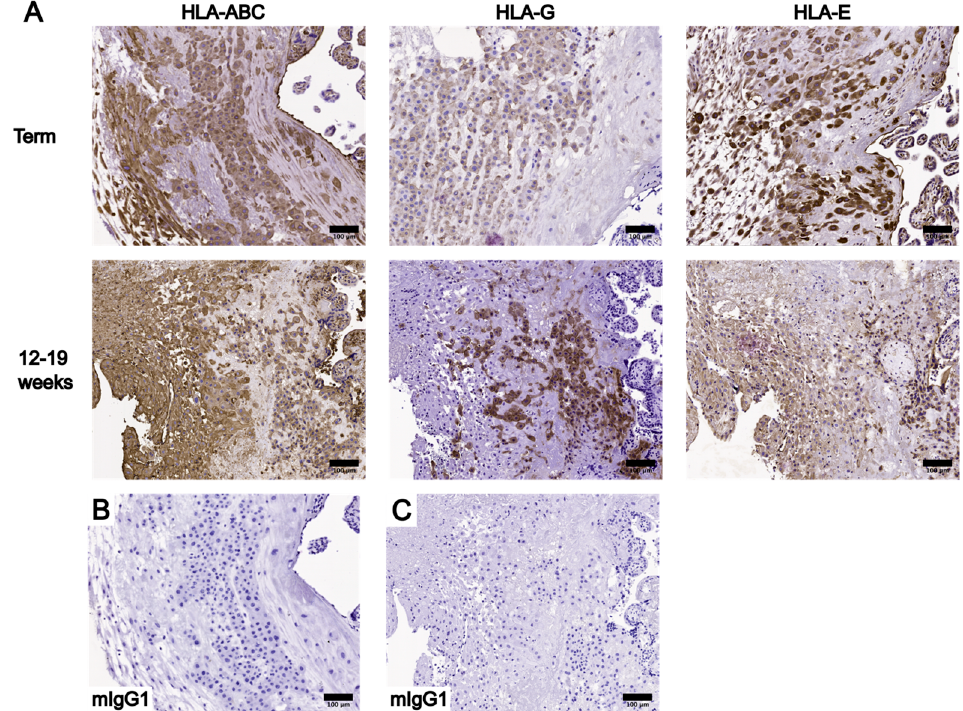
Figure 1. Summary of the immunohistochemstry (IHC) staining results of HLA-ABC, HLA-G, and HLA-E in placental tissue sections at the decidua using the optimized primary antibody working concentrations. ( A ) Placental tissue sections at term and between 12 and 19 weeks stained with HLA-ABC (0.25 µg/mL), HLA-G (2.0µg/mL), and HLA-E (5.0 µg/mL). ( B ) Negative control of term placental IHC staining results using an anti-mouse IgG1 (mIgG1) antibody. ( C ) Negative control of 12–19 week placental IHC staining results using an anti-mIgG1 antibody. Scale bars = 100 µm.